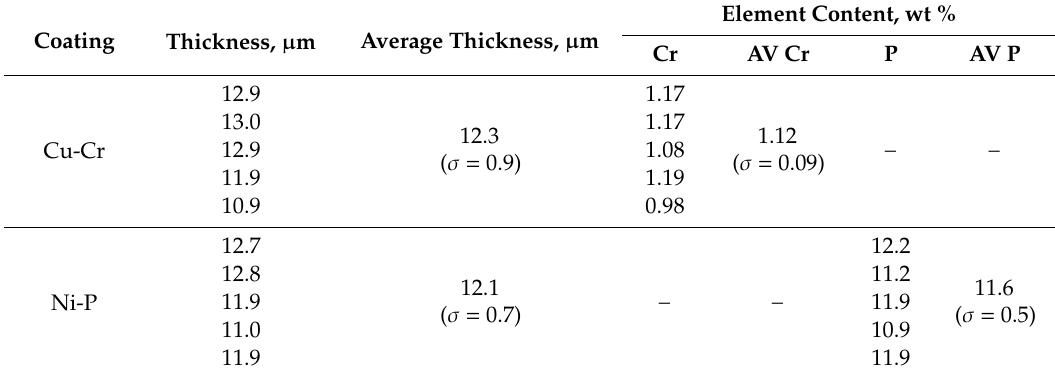
Table 3. Thickness and composition of the deposited coatings.